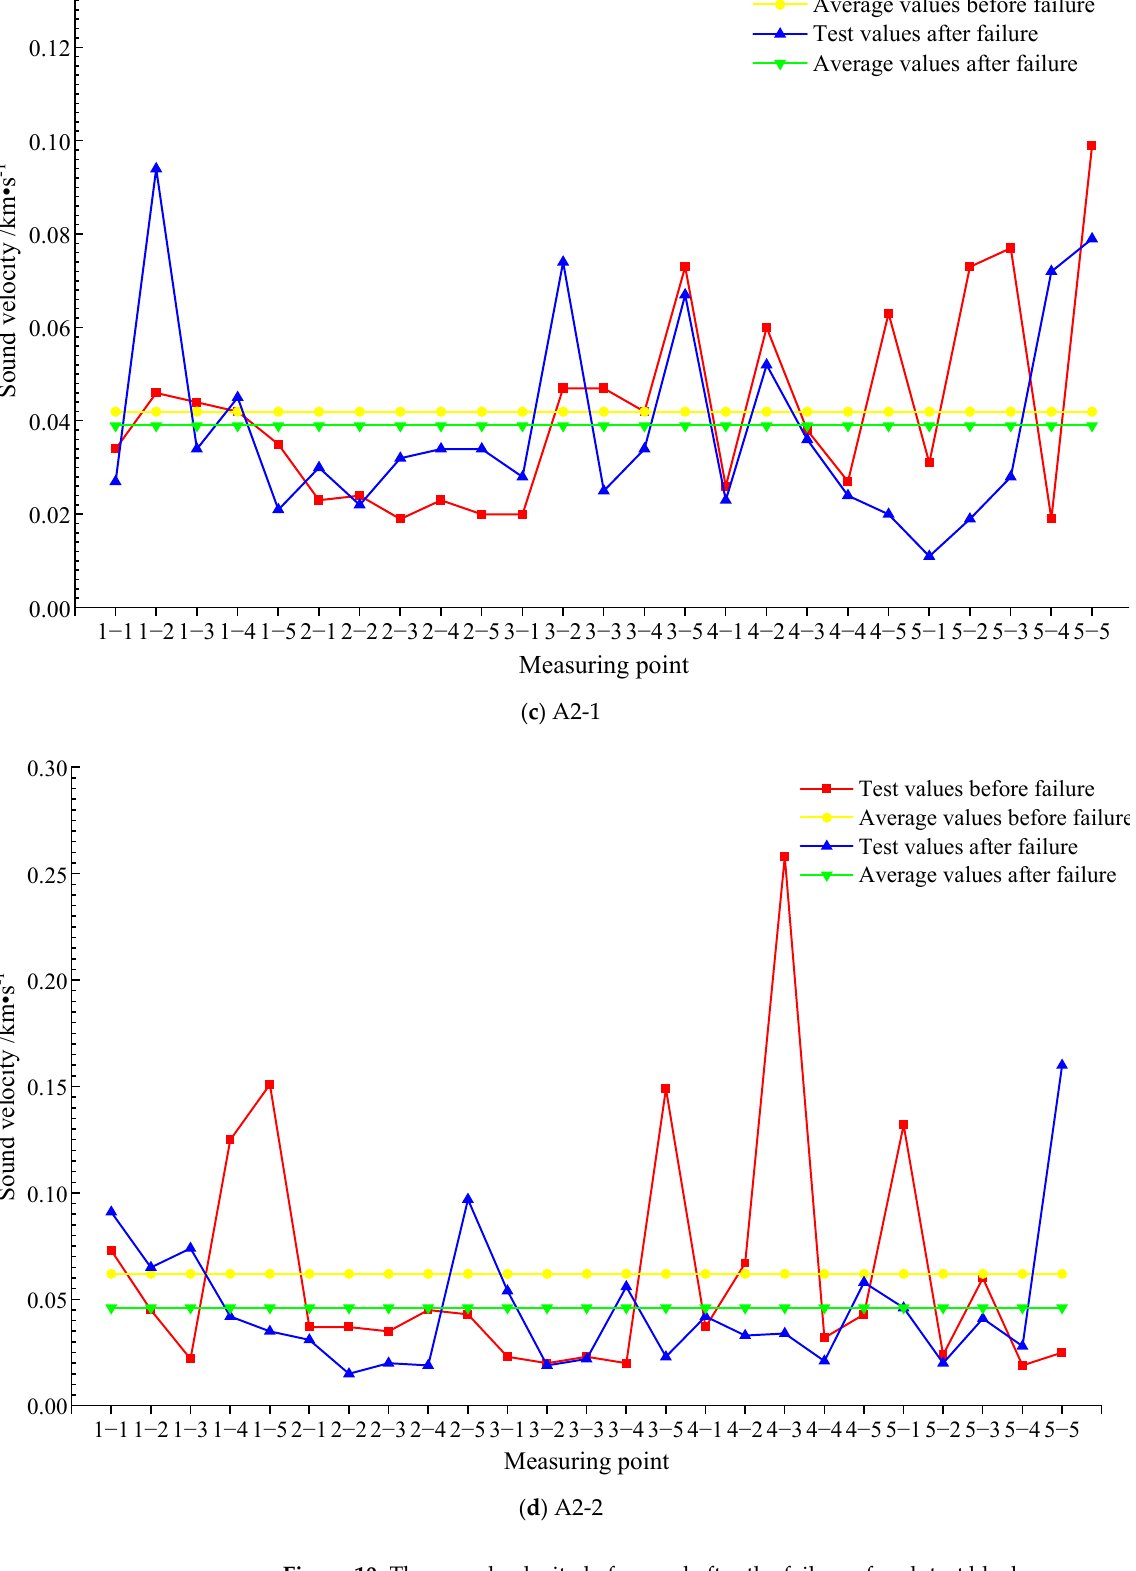
Figure 10. The sound velocity before and after the failure of each test